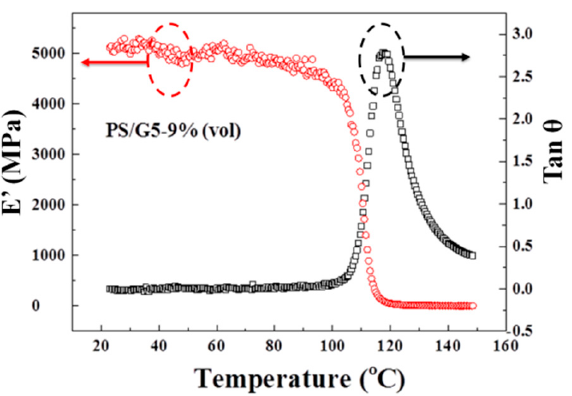
Figure 5. ε ’ and tan θ of the dynamic mechanical analysis (DMA) measurement for PS/G5-9% from 25 °C to 150 °C at 1 Hz.